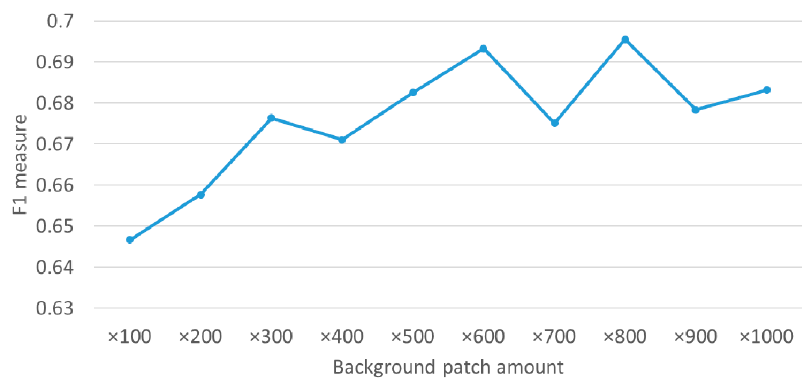
Figure 14. All F1 scores by the normal method including the additional experiments. The score does not seem to have improved after